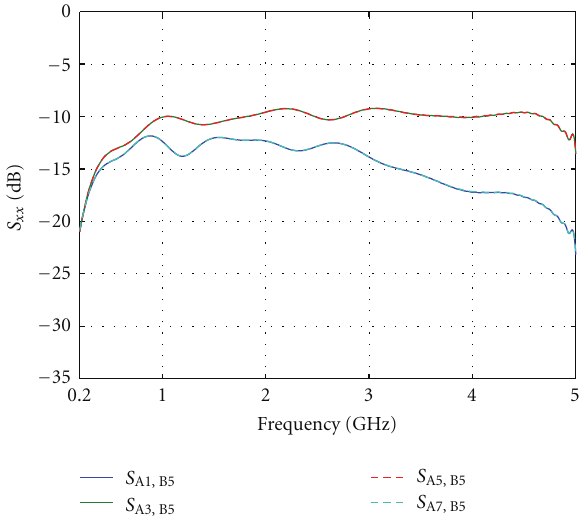
Figure 6: Comparison of reflection coe ffi cient between the analyt- ical model and simulation.